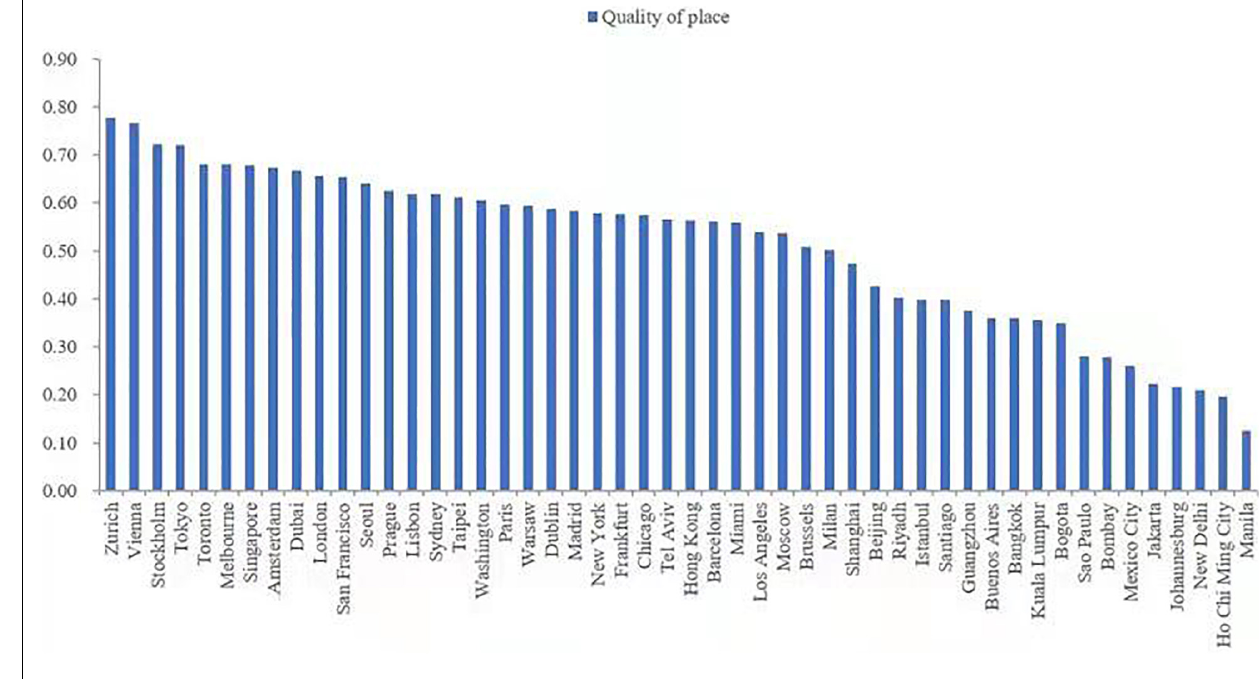
FIGURE 2 | Results for quality of place measurement.